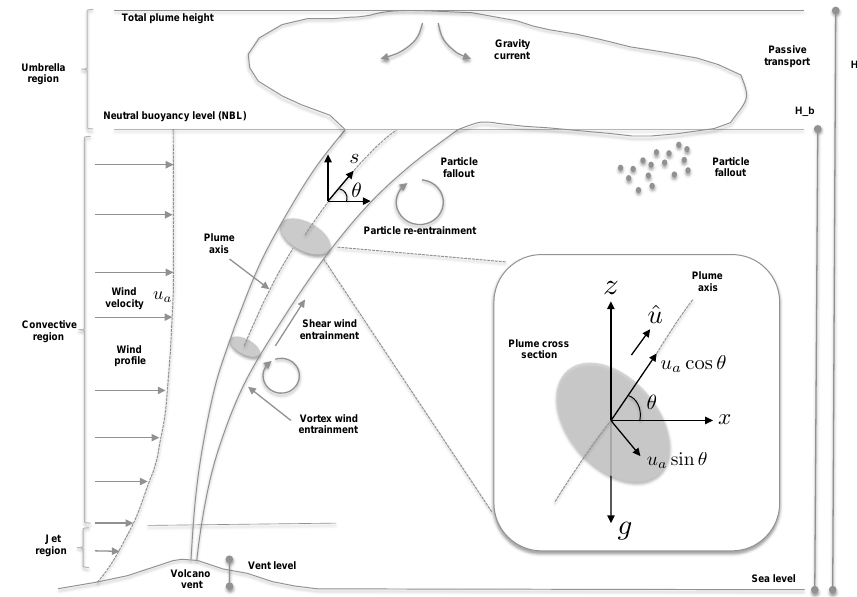
Figure 1. Sketch of an axisymmetric volcanic plume raising in a wind profile. Three different regions (jet thrust, convective thrust and umbrella) are indicated, with the convective region reaching a height H b (that of the neutral buoyancy level), and the umbrella region raising up to H t above the sea level (a.s.l.). The inset plot details a plume cross section perpendicular to the plume axis, inclined of an angle θ with respect to the